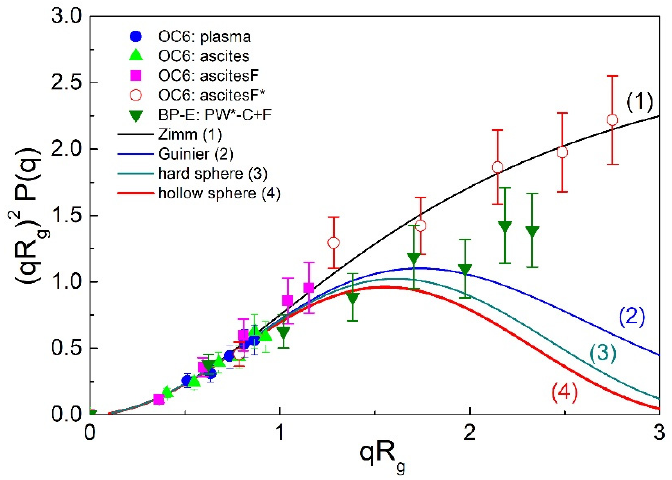
Figure 4. The Kratky plot for four selected particle topologies (solid lines 1–4; for details see Equation (S7a–d) in Supplementary Materials and ref. [38]) and the experimental data for ovarian cancer (OC) patients OC5 and OC6 (the full circles, squares, and triangles apply to small ENPs and the open circles to large ENPs) and for the patient with endometriosis as benign pathology (BP-E) (full down triangles).